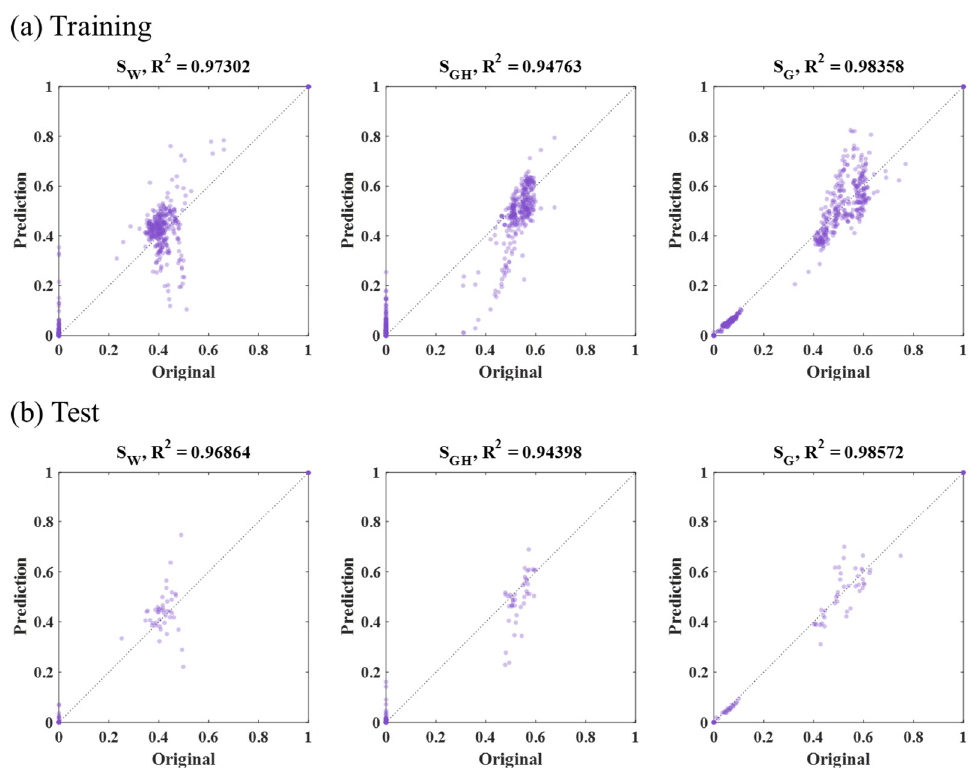
Figure 14. The training ( a ) and test ( b ) results from the CNN with the 1-D horizontal input data (Figure 8c).